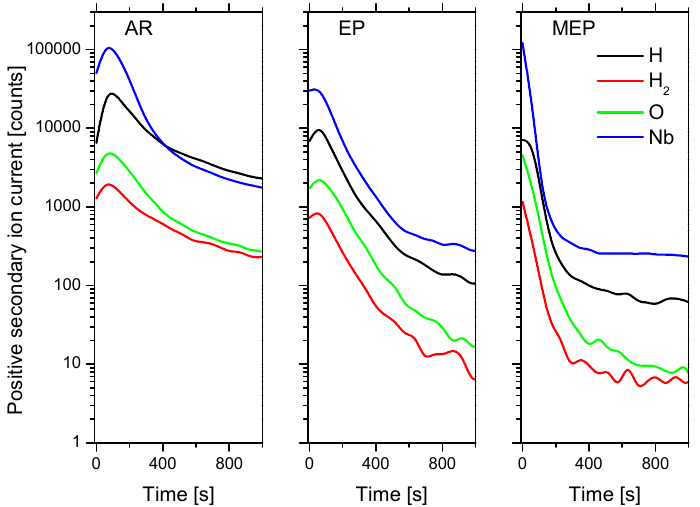
1.35 mm × 1.35 mm.